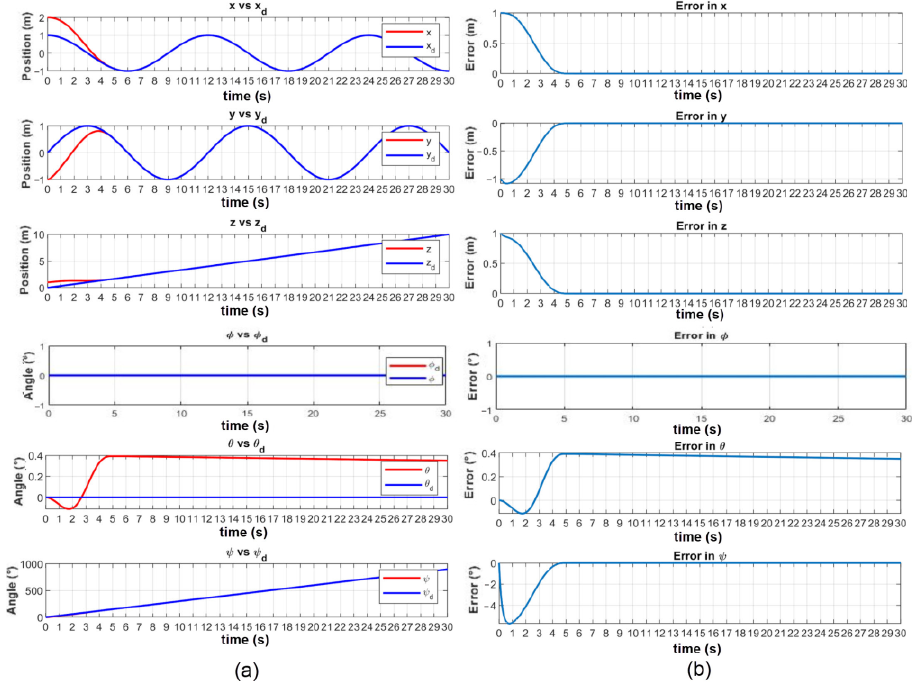
Figure 11. Results for the finite-time convergence controller subject to ocean currents and t b = 5 s. ( a ) Trajectory tracking. ( b ) Position tracking errors. A three-dimensional trajectory of the BlueROV2 simulation along with the control trajectory when subject to ocean currents can be seen in Figure 12.